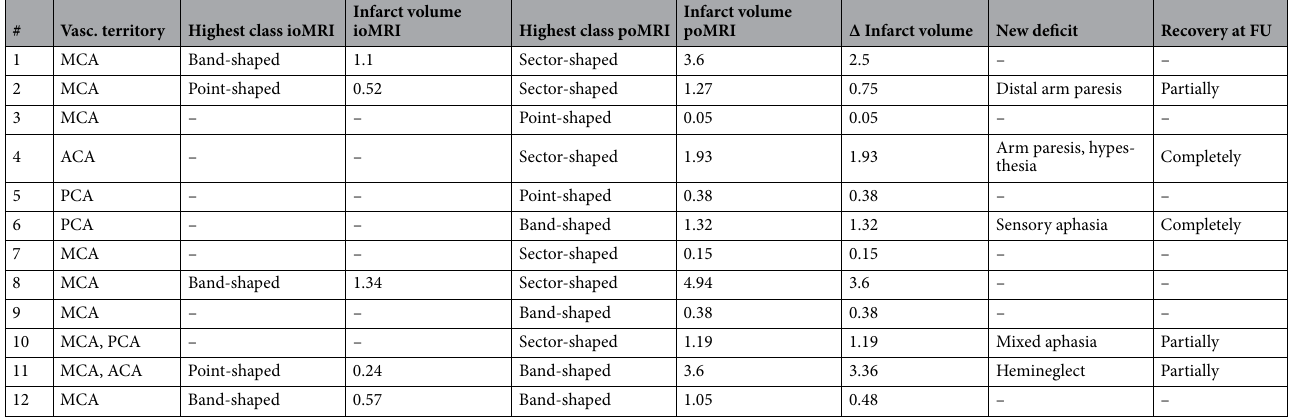
Table 2. Case series infarct and clinical outcome characteristics. Infarct volumes in cm 3 . All pre- and postoperative infarcts were adjacent to the resection cavity. Remote infarcts with no spatial relationship to the surgery or the approach were not considered. # patient number, Vas. vascular, MCA middle cerebral